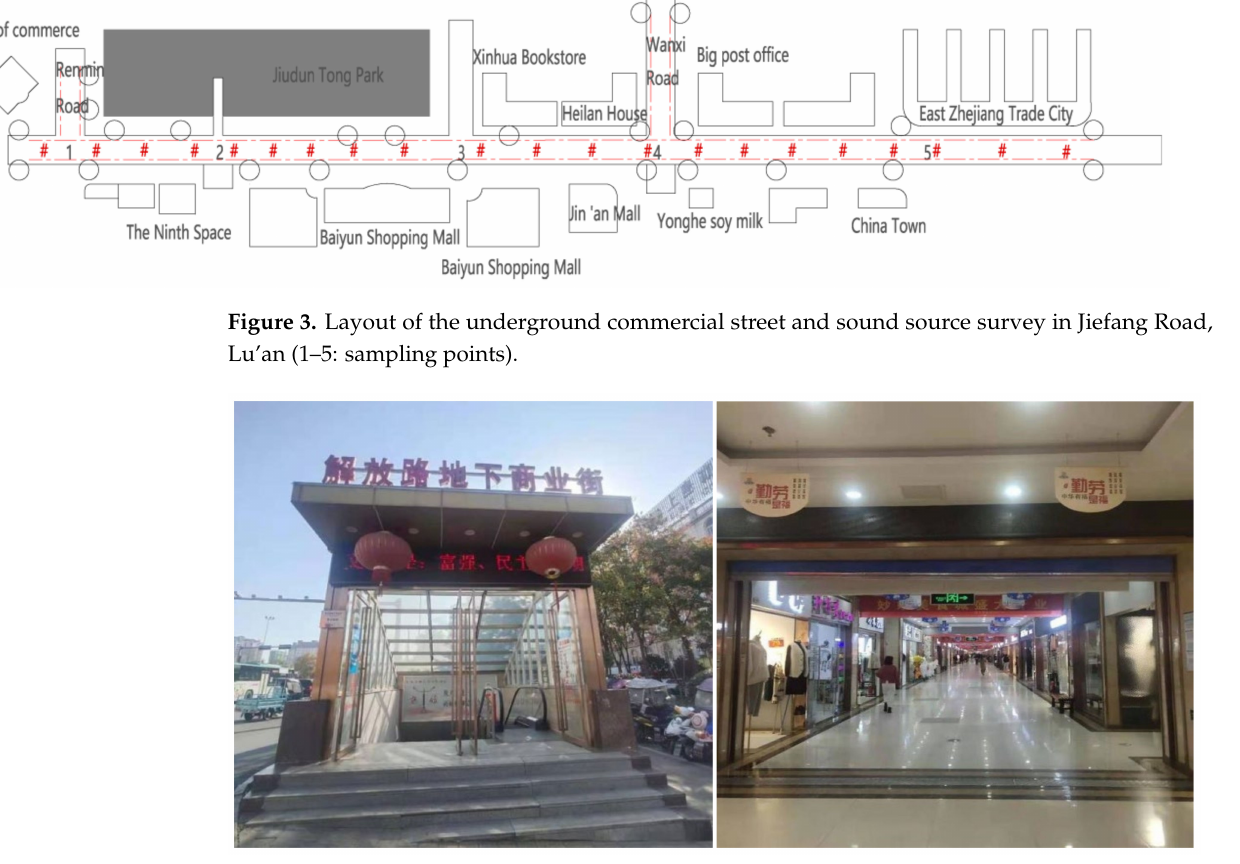
Figure 4. Pictures of the underground commercial street on Jiefang Road in Lu’an